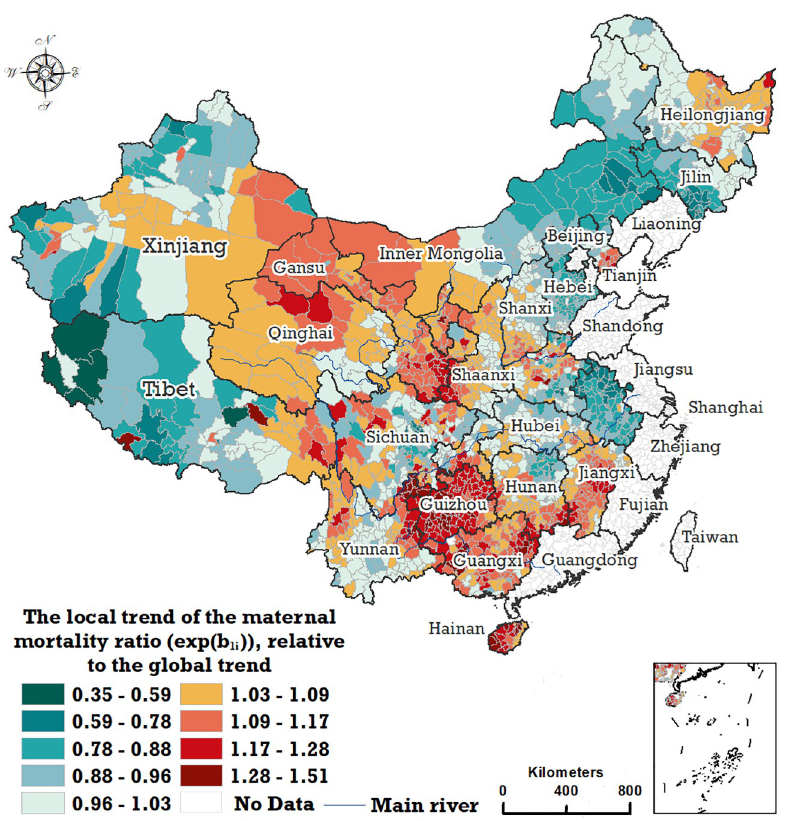
Fig 4. The local trend of the MMR in 2,205 counties, relative to the global trend, with the posterior medians of the parameter exp ( b 1i ). MMR, maternal mortality ratio.